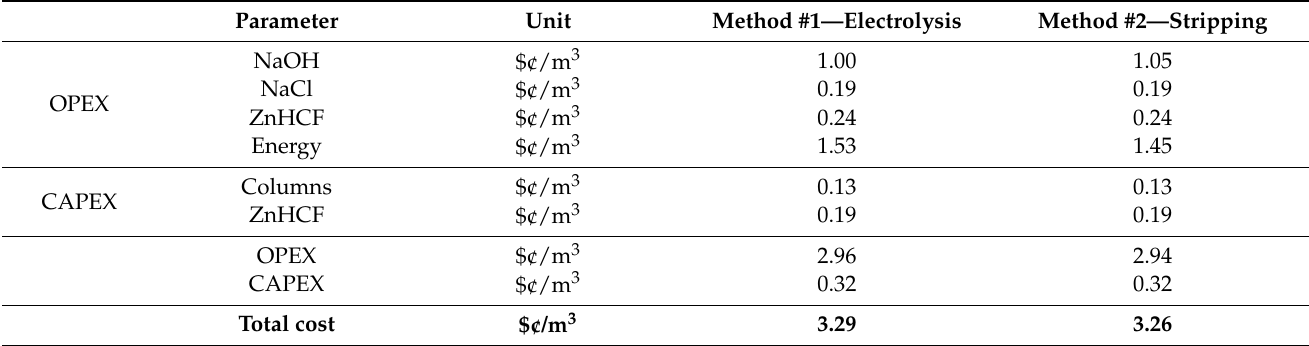
Table 6. Cost analysis of the proposed process, showing the analysis for the two proposed methods for TAN removal from the exhausted regeneration